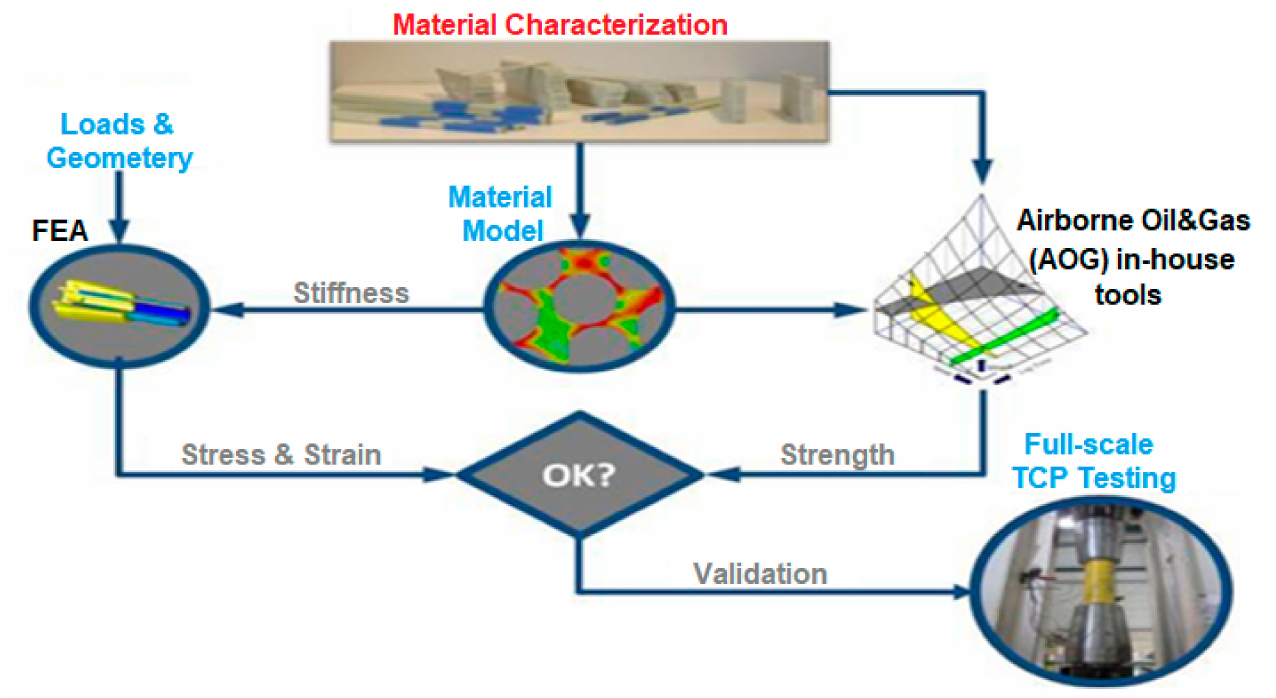
Figure 7. Design procedure for TCP material characterisation. (Courtesy of Airborne Oil&Gas).